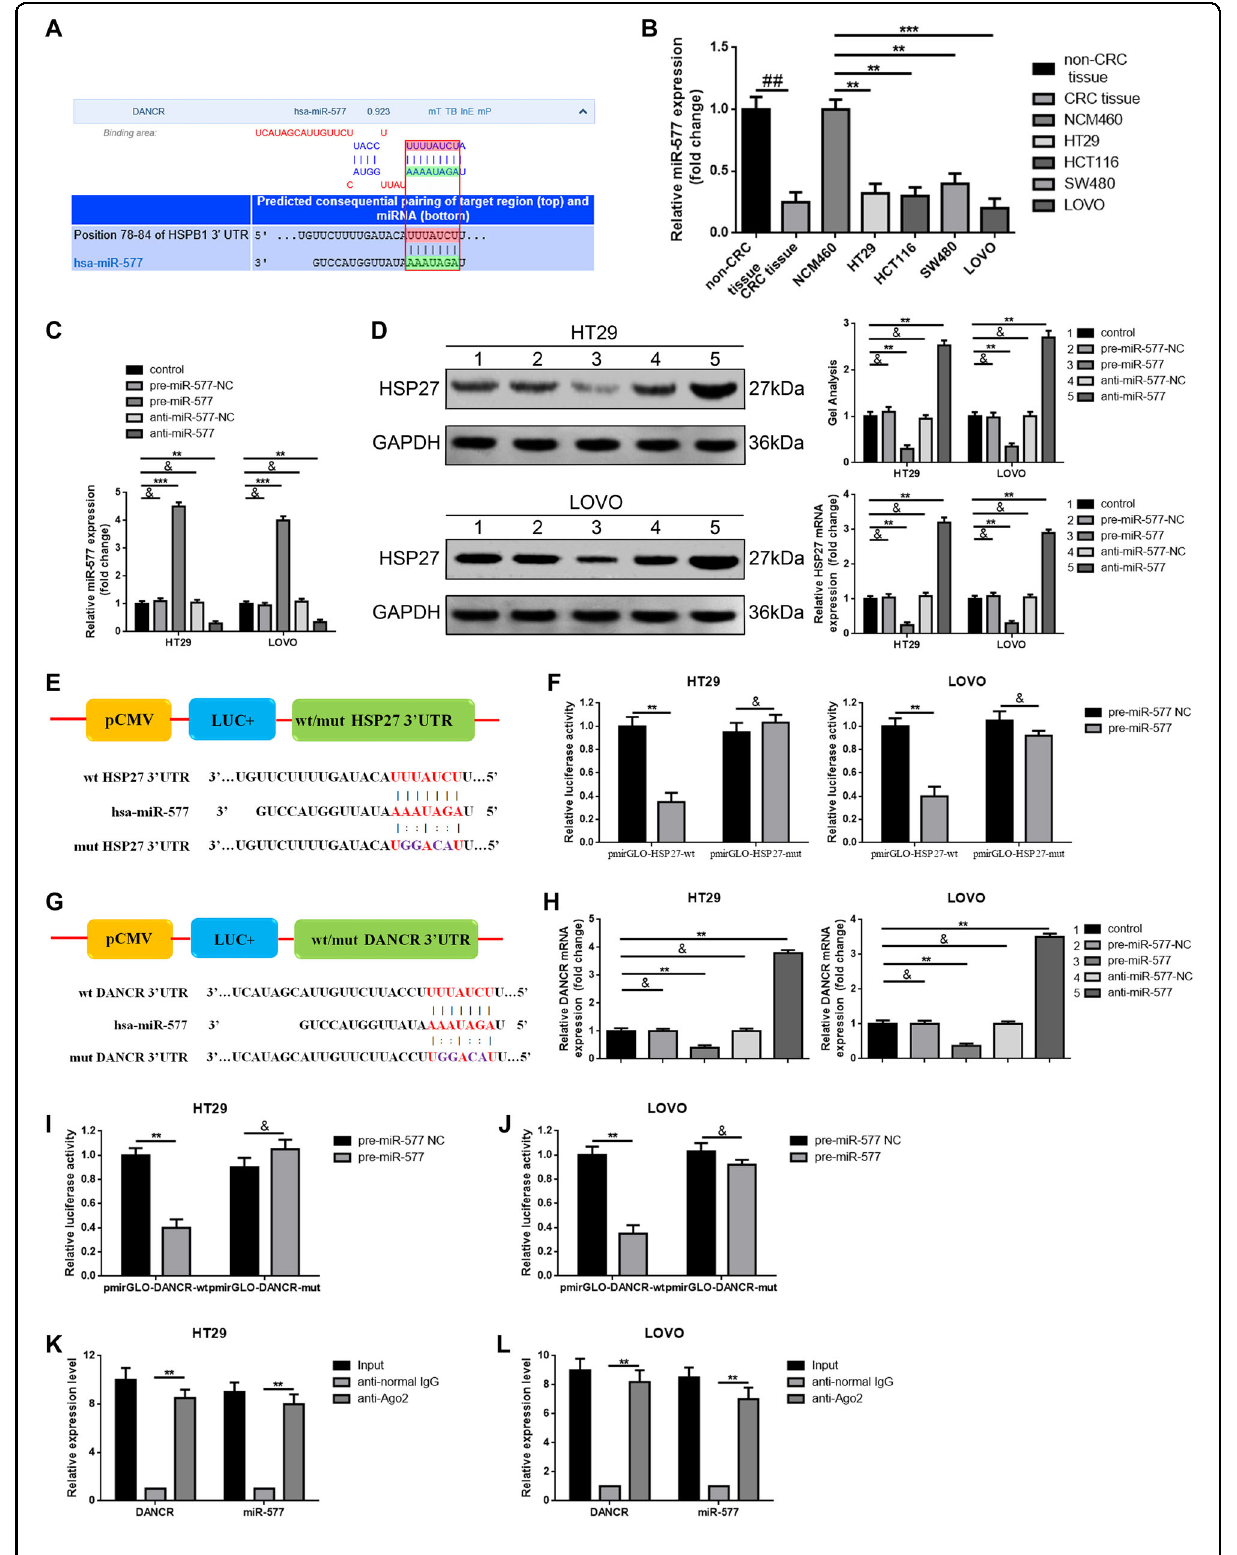
Fig. 4 (See legend on next